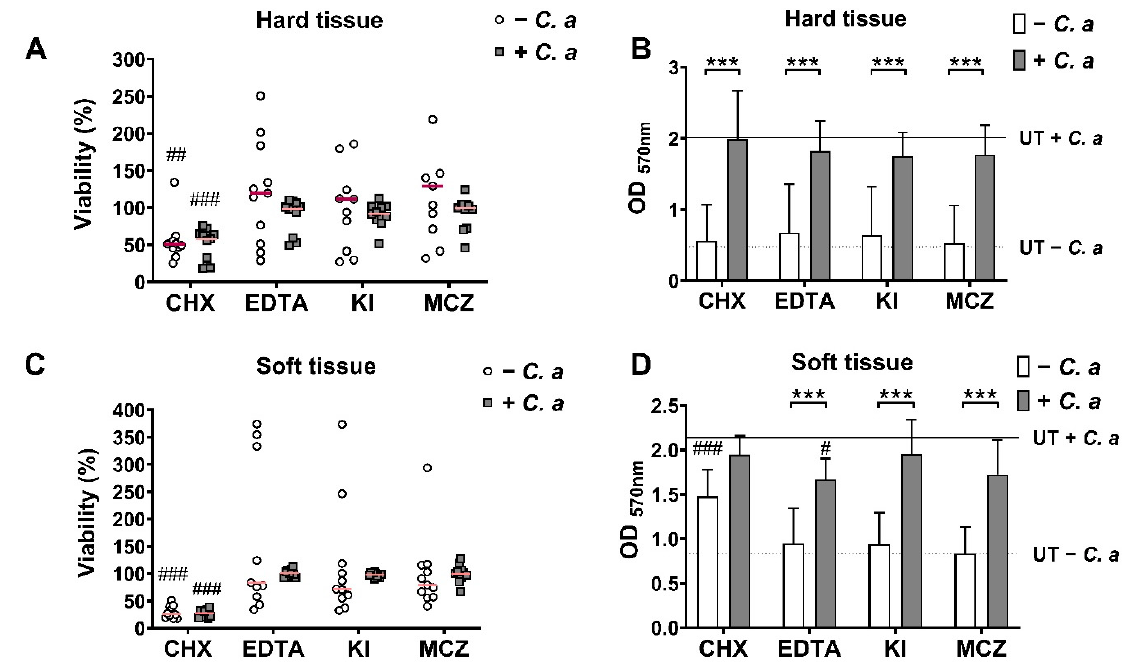
Figure 5. Treatment outcomes of hard and soft tissue biofilms with or without C. albicans . After maturation, biofilms were treated with 0.2% CHX, 4% EDTA, 1% KI or 40 µg/mL MCZ for 10 min at room temperature. Alamar blue™ dye was used to assess metabolic activity was calculated against an untreated control (HT biofilm ( A ) and ST biofilm ( C )). Data represent mean ± SD, carried out in triplicate in three independent experiments. A Mann–Whitney t test was carried out on the raw metabolic activity data to assess significant differences between untreated (UT) and treated biofilms (## p < 0.01, ### p < 0.001). Following metabolic assessment, biofilms were dried overnight at room temperature and biomass was determined via crystal violet staining (HT biofilm ( B ) and ST biofilm ( D )). A dotted black line has been drawn to illustrate the average results of the UT control— C. albicans , and a black solid line entered to show the UT control + C. albicans . Data represent mean ± SD, carried out in triplicate or quadruplicate on three independent experiments (a total of 11 replicates from 3 separate experiments). A Mann–Whitney t test was used to compare significant differences between UT biofilms and treated biofilms (# p < 0.05, ### p < 0.001, *** p <